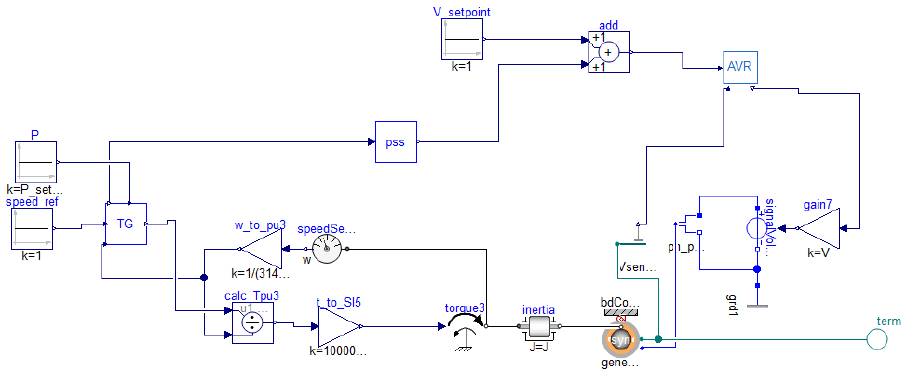
Figure A1. Modelica’s synchronous generator model.